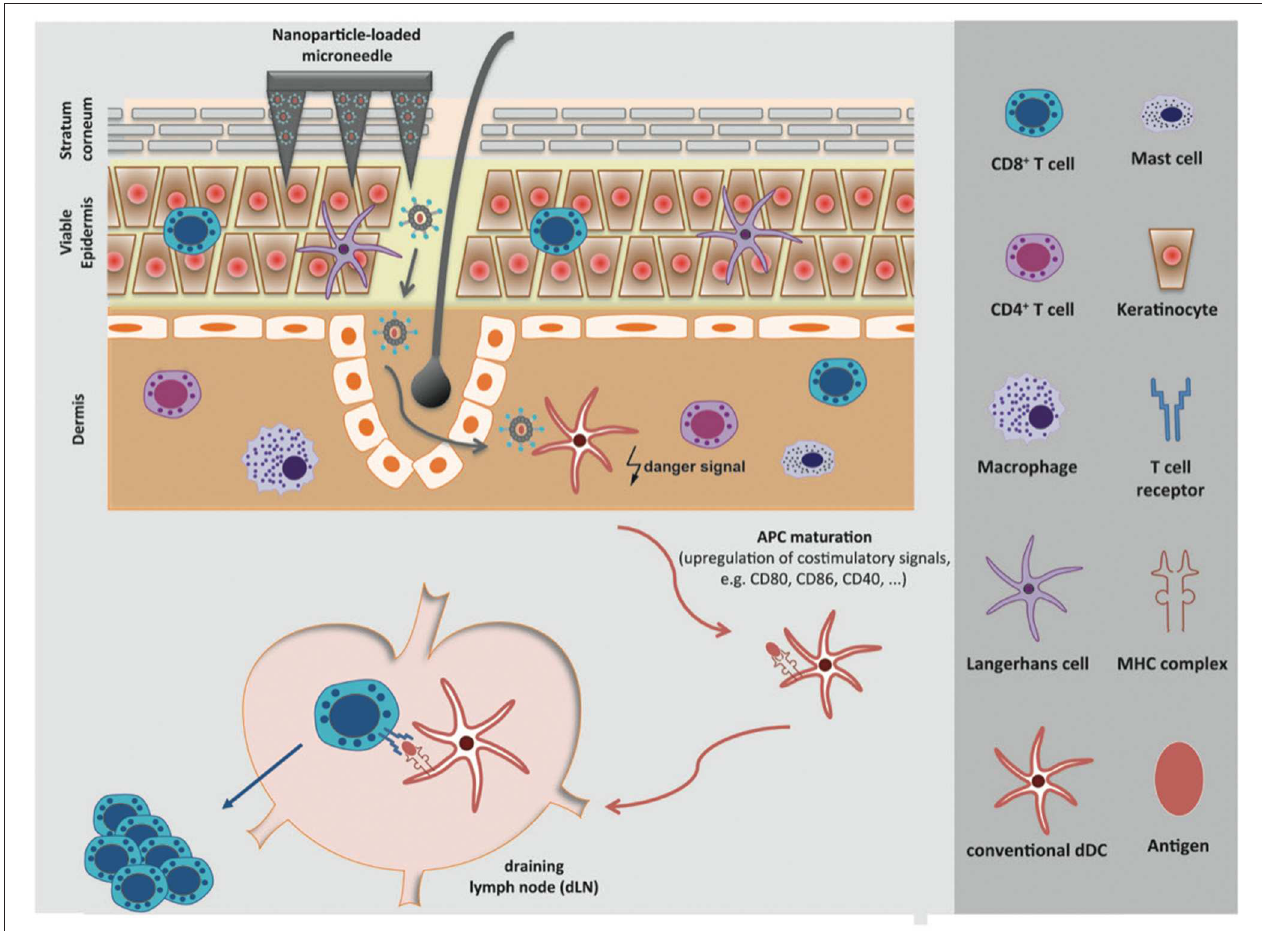
FIGURE 1 | Overcoming the stratum corneum with particle-based systems and targeting of the APC network in the skin. Particle-based systems for transdermal vaccine delivery facilitate the targeting of the versatile network of skin-resident antigen-presenting cells (APCs). Activated APCs incorporate an antigen and migrate to the draining lymph node (dLN) where naive T cells are primed, thereby enabling an antigen-specific cellular immune response.